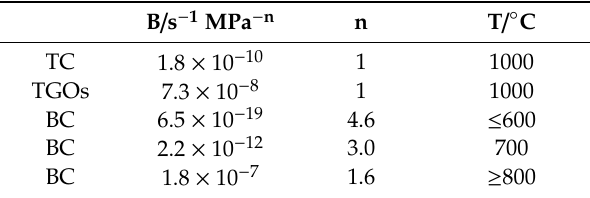
Table 3. Creep parameters of